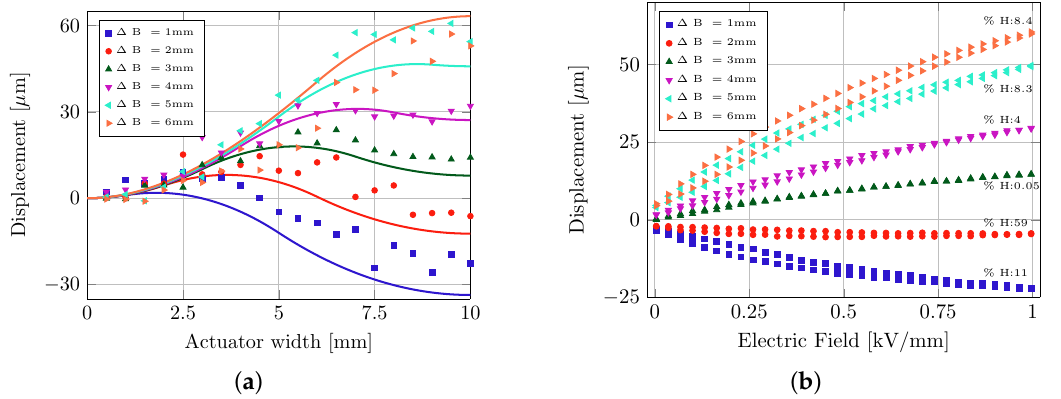
Figure 5. ( a ) Numerically simulated (solid lines) and experimentally measured (bold markers) bending lines of a quarter actuator model. ( b ) Hysteresis curves for a parametric variation of ∆